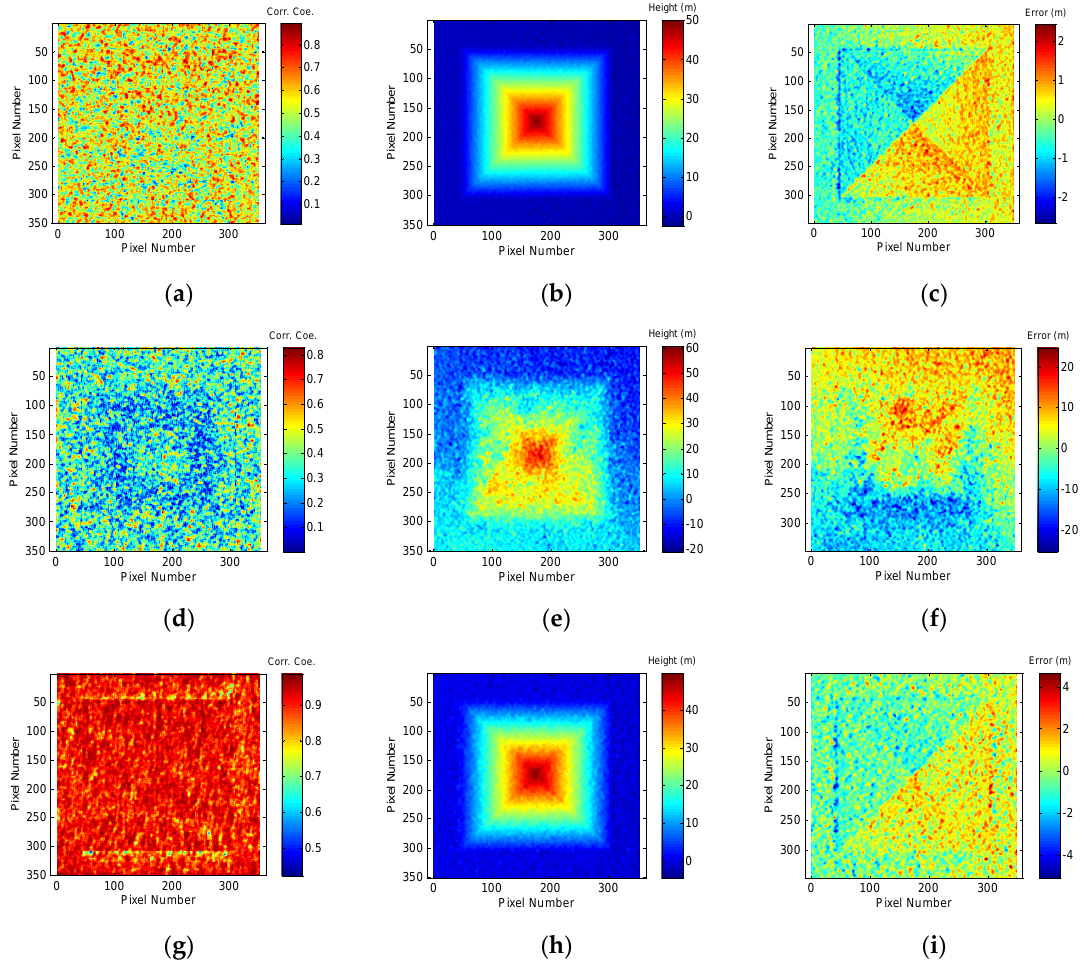
Figure 10. InSAR simulation results. ( a ) The correlation coefficient (corr. coe.), with a mean value of 0.53; ( b ) Retrieved height; ( c ) Retrieval error, with a mean value of 0.67 m of the SAR pairs acquired from the formation by the proposed method; ( d ) Corr. coe., with a mean value of 0.33; ( e ) Retrieved height; ( f ) Retrieval error, with a mean value of 7.62 m of the SAR pairs acquired from the formation by ECI-RME, without optimal data acquisition; ( g ) Corr. coe., with a mean value of 0.90; ( h ) Retrieved height; ( i ) Retrieval error, with a mean value of 1.01m of the SAR pairs acquired from the formation by ECI-RME, the optimal data acquisition was conducted.